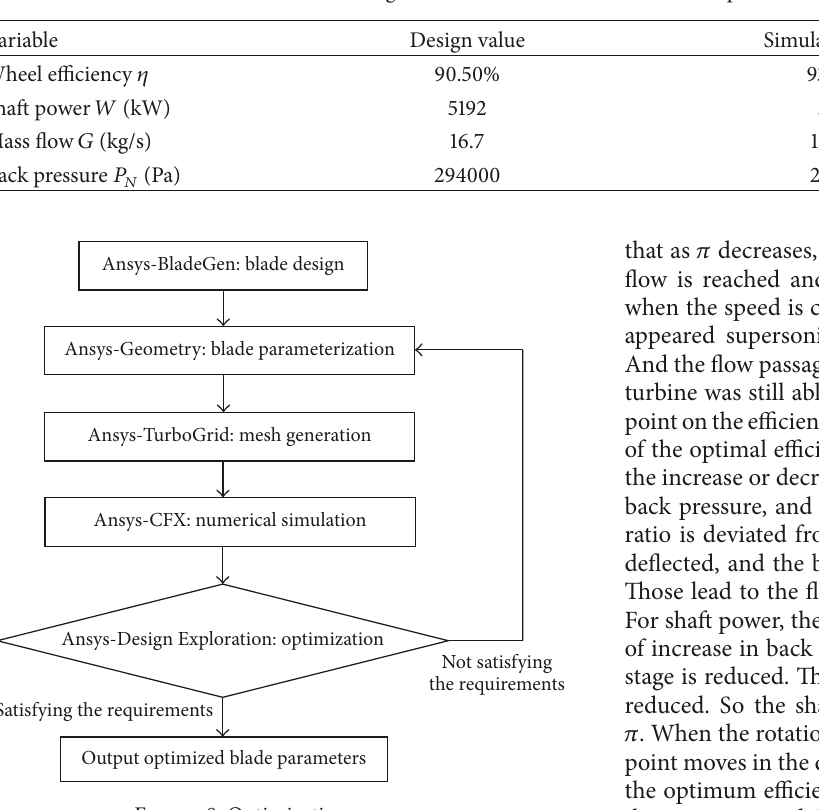
Figure 8: Optimization